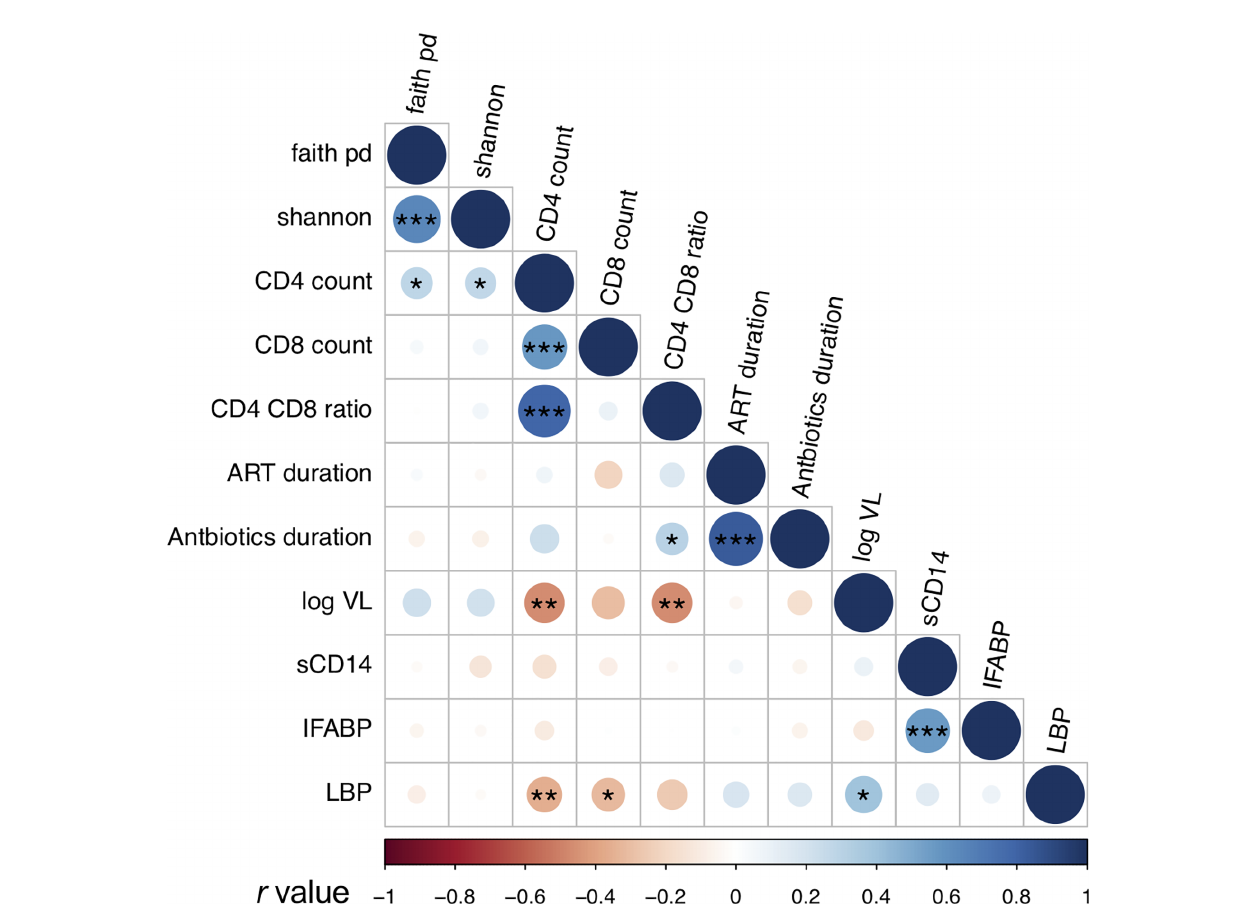
FIGURE 6 | Analyses of correlation between fecal microbiome diversity and clinical markers. Asterisks indicate signi fi cant correlation determined by Spearman ’ s test; *, **, and *** indicate signi fi cant differences with p < 0.05, p < 0.01 and p < 0.005, respectively. Circle sizes are proportional to strength of correlation. Faith_pd, Faith ’ s phylogenetic diversity; shannon, Shannon ’ s index; ART_duration, duration under ART; Antibiotics_duration, duration since last Co-trimoxazole treatment; log_VL, viral load; sCD14, plasma soluble CD14 levels; IFABP, plasma intestinal fatty acid-binding protein levels; LBP, plasma lipopolysaccharide binding protein levels. n = 110 in faith_pd, shannon, sCD14, IFABP, and LBP; n = 55 (HIV+) in CD4 count, CD8 count, and CD4_CD8_ratio; n = 52 in ART_duration; n = 54 in Antibiotics_duration, n = 36 in log_VL (> 20